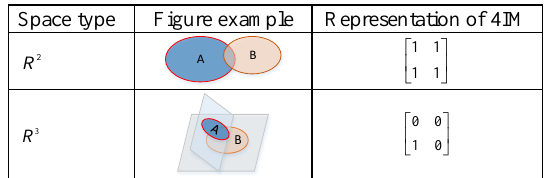
Table 1. The differences of topological relations between two regions in 2 R and 3